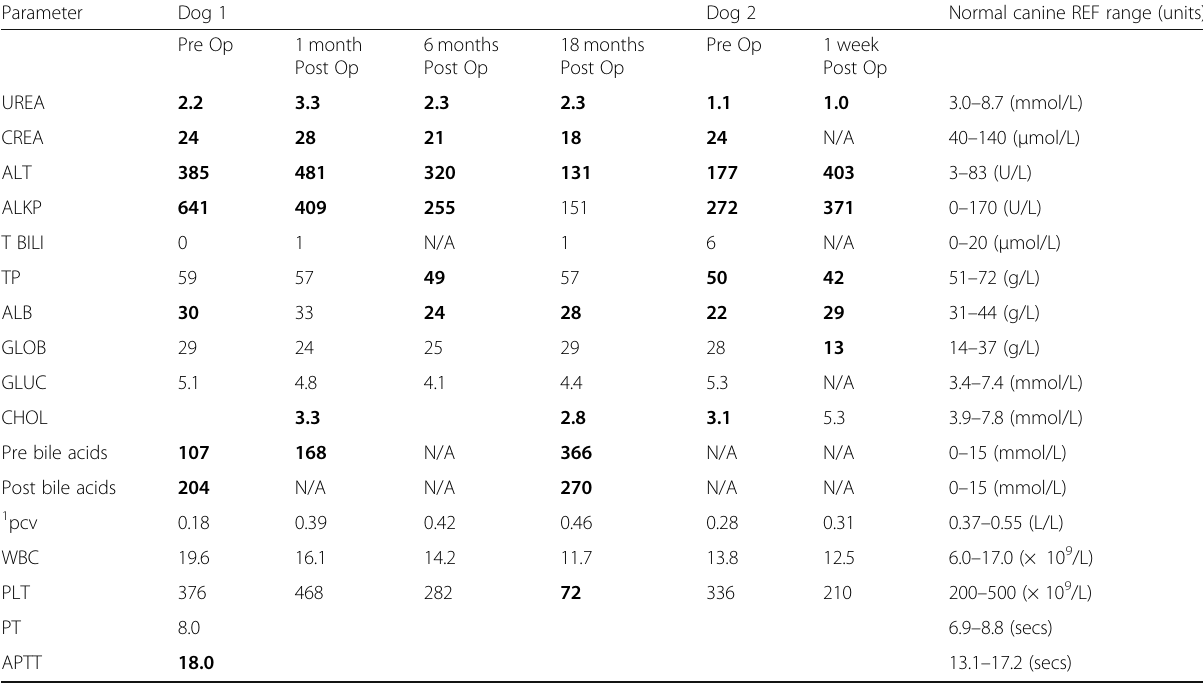
Table 1 Selected biochemical and haematology parameters at various pre and post procedure timepoints for Dog 1 and Dog 2. Bold values represent values outside the normal canine reference ranges